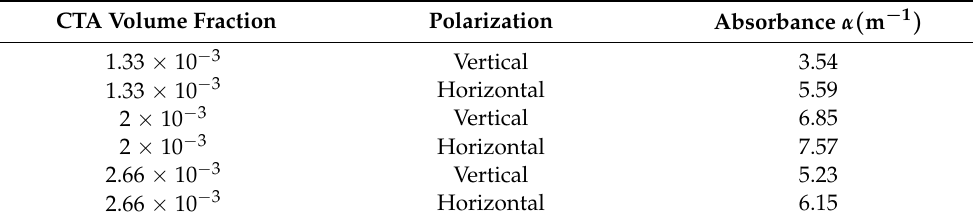
Table 4. Absorbance as a function of CTA volume fraction and light polarization at